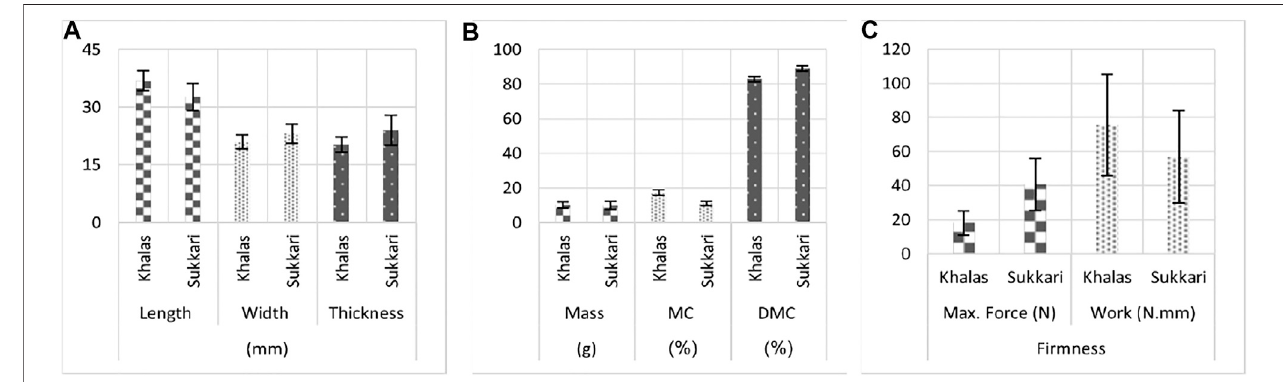
FIGURE 3 | Mean and standard deviation of length, width, and thickness (A) ; mass, MC, and DMC (B) ; and fi rmness attribute (C) of Khalas and Sukkari